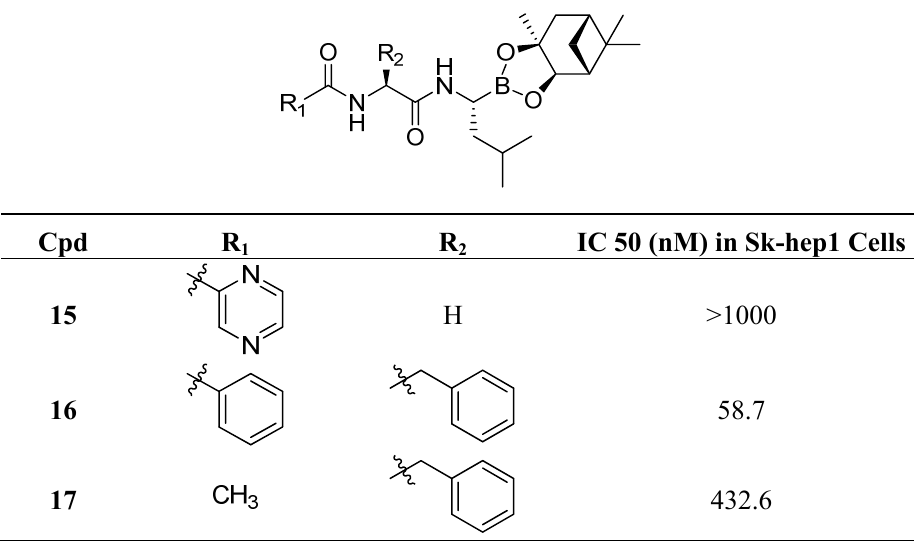
of growth inhibition in Sk-hep-1 50